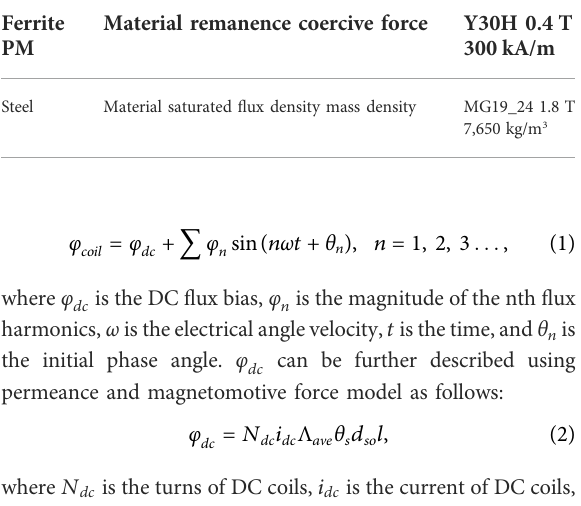
TABLE 2 Design parameters for the proposed machine. TABLE 3 Major parameters and speci fi